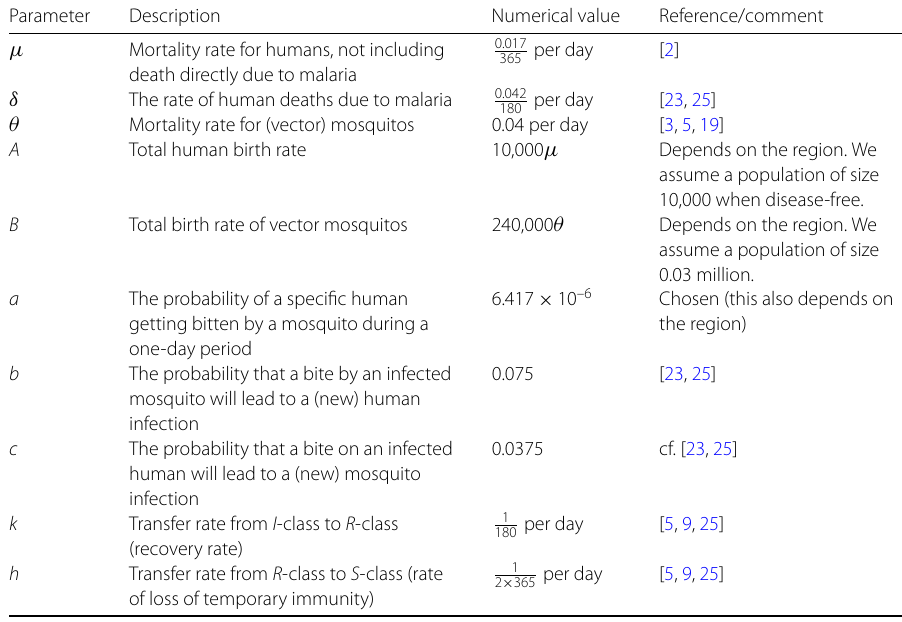
Table 1 Numerical values of